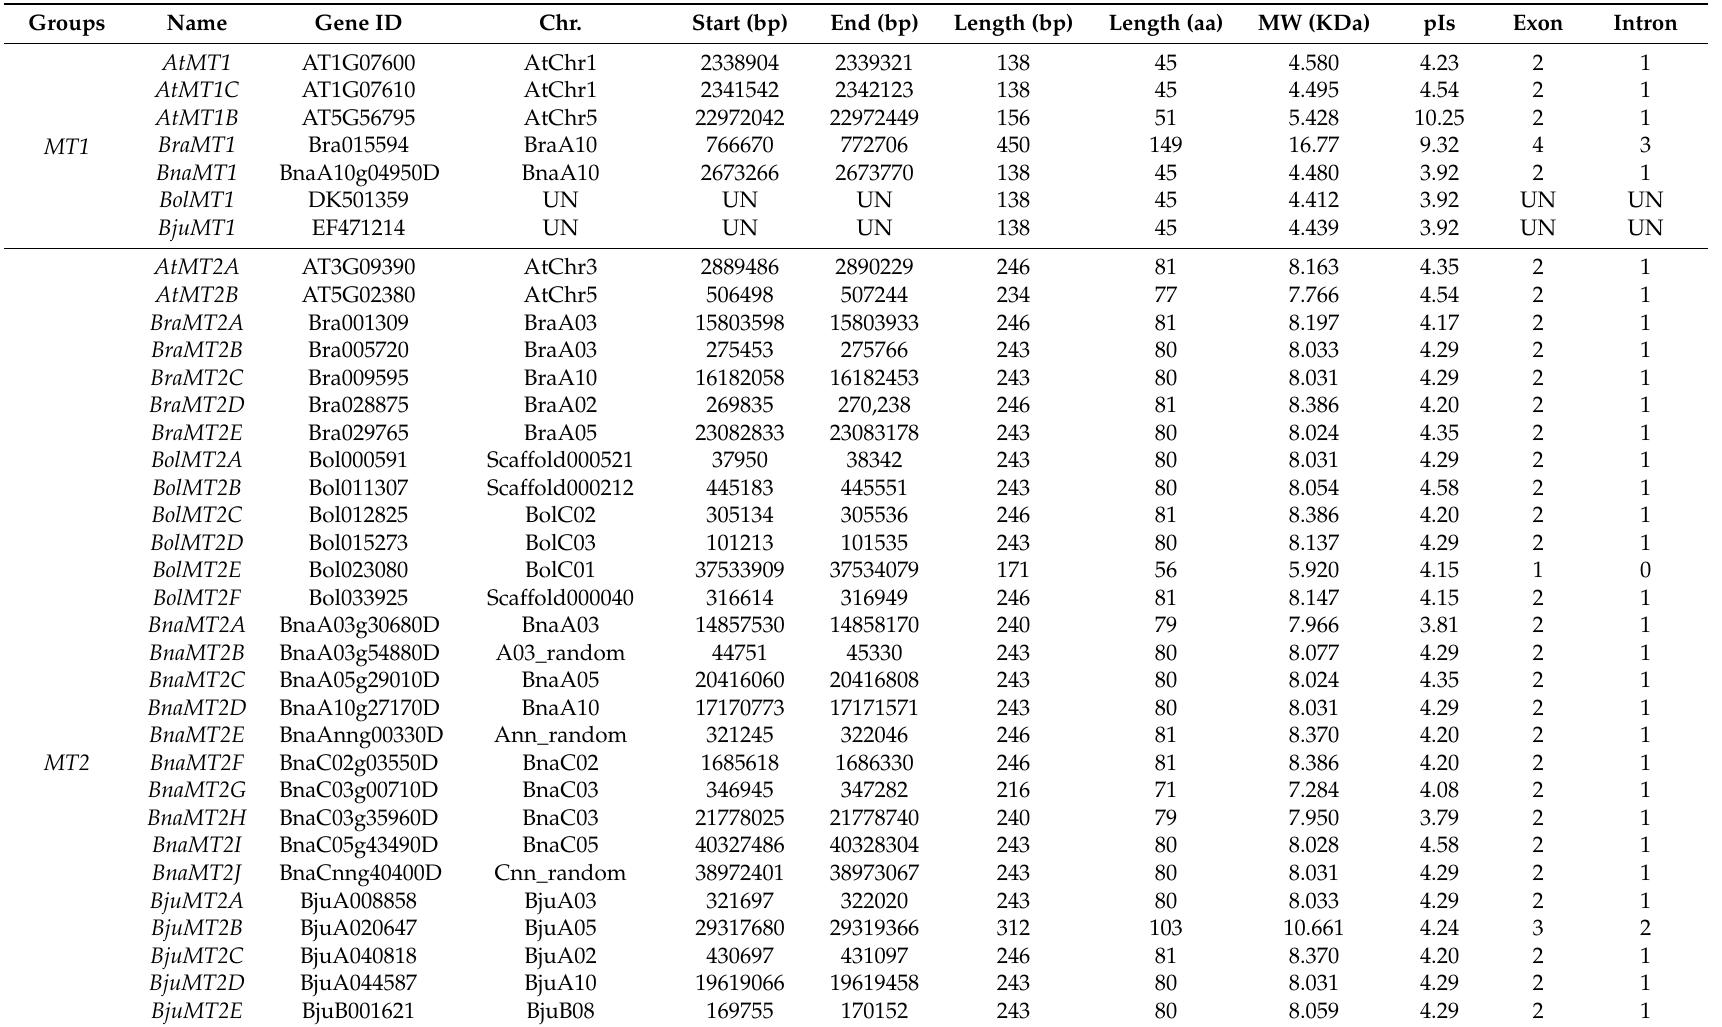
Table 1. List of Metallothionein ( MT ) genes identified in the A. thaliana and Brassica